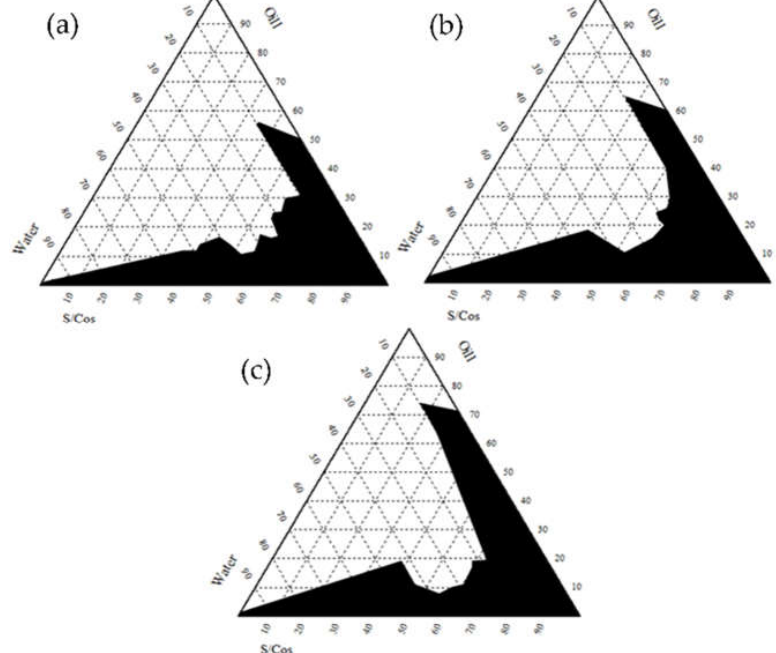
Figure 3. Pseudo-ternary phase diagram of oil (IPM), surfactant (Cremophor EL ® )-co-surfactant (Transcutol ® HP) and water ( a ) Cremophor EL ® :Transcutol ® HP (2:1, w / w ); ( b ) Cremophor EL ® :Transcutol ® HP (3:1, w / w ); and ( c ) Cremophor EL ® :Transcutol ® HP (4:1, w / w ).